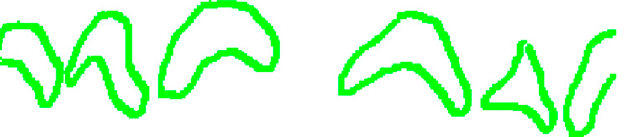
Figure 9. Shows the contours of the erosion area, extrapolated from the main image.